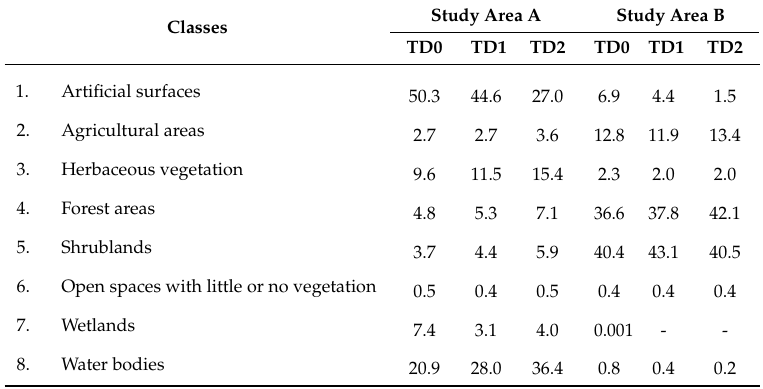
Table 7. Percentage of the TD0, TD1 and TD2 datasets belonging to each class for study areas A and B. Study Area Classes